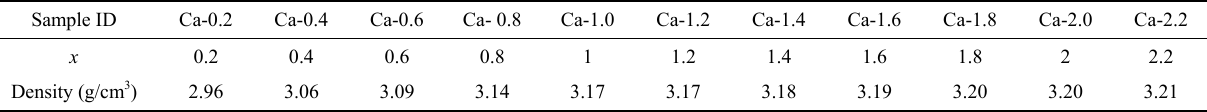
Table 2 Density of calcium stabilized nitrogen rich  -sialon sintered at 1500 ℃